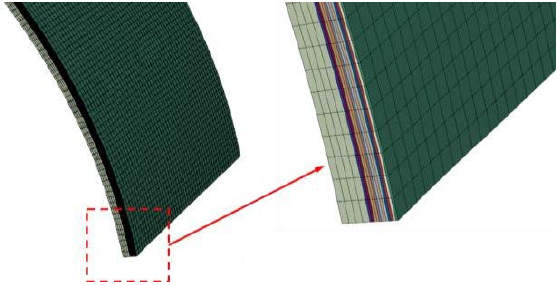
Figure 4. Model meshing.